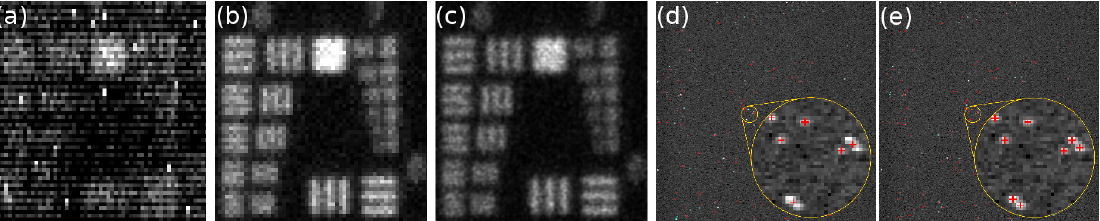
Figure 3. ( a – c ) Images of a USAF test pattern obtained by photon counting imaging with a Hamamatsu EBCCD: ( a ) sum of 30,000 frames; ( b ) 1-pixel centroiding; ( c ) 1/5-pixel centroiding. With 1 pixel centroiding, the photon event is assigned to the to the center pixel of the event and the edges are ignored. With 1/5 pixel centroiding, each pixel is divided into 5 × 5 subpixels, and each photon event is assigned a sub-pixel according to the centroid position calculated by the sub-pixel localisation algorithm; ( d – e ) A raw frame of USAF data with photon positions localised with super-resolution software marked with red crosses. Overlapping events that are normally counted as one event ( d ) are resolved with multi-emitter fitting analysis ( e )